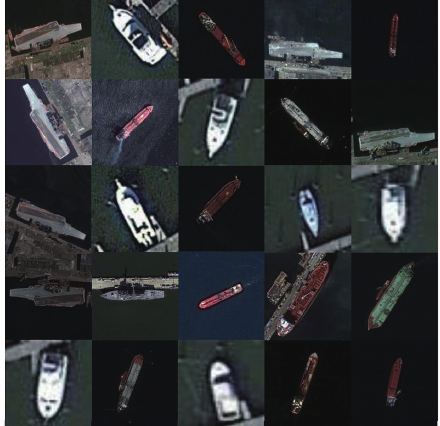
Figure 1. Examples of objects with various orientations in satellite optical